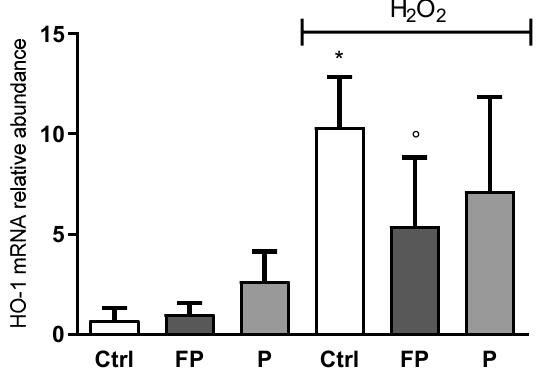
Figure 4. HUVECs were plated in 6-well plates (1.5 × 10 5 cells/well) and treated with 10 µg/mL of FP and P for 24 h followed by injury with H 2 O 2 (300 µM) for 24 h. HO-1 gene expression was assessed using qRT-PCR analysis. Gene expression levels were calculated using the 2 − ∆∆ Ct method and RPL13A as reference gene. Results are expressed as mean ± SD of at least three experiments. * p < 0.05 significantly different from the control (ctrl). ◦ p < 0.05, significantly different from H 2 O 2 - treated HUVECs. Ctrl (control, untreated cells); H 2 O 2 (cells treated with hydrogen peroxide); FP (cells pretreated with fermented Pushgay); P (cells pretreated with